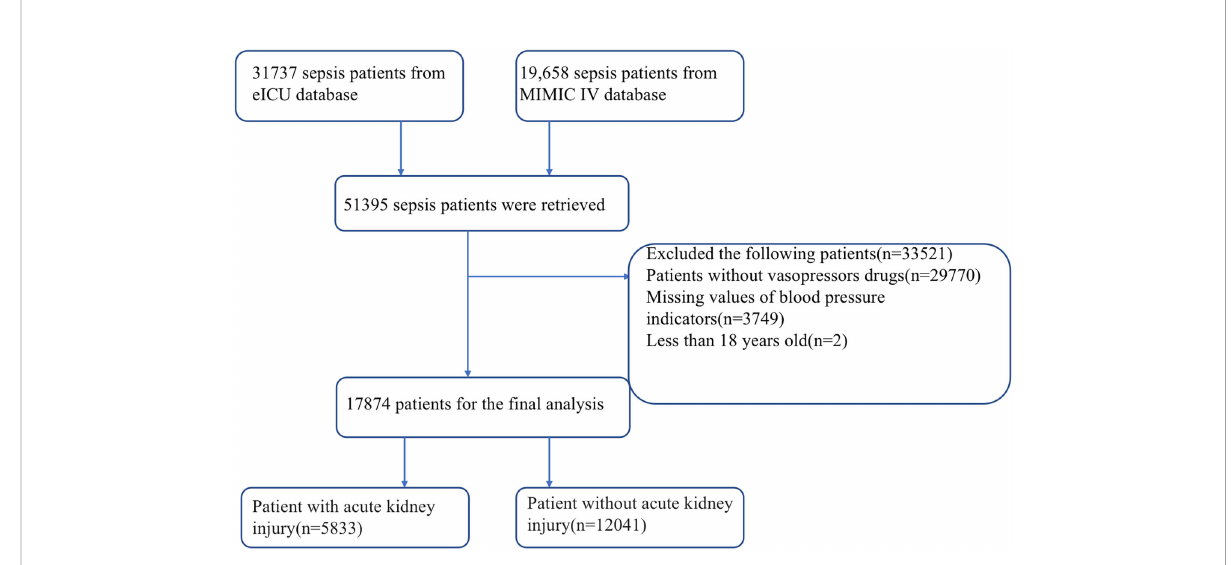
FIGURE 1 Flow chart for patient selection. ICU, intensive care unit; MIMIC-IV, Medical Information Mart for Intensive Care